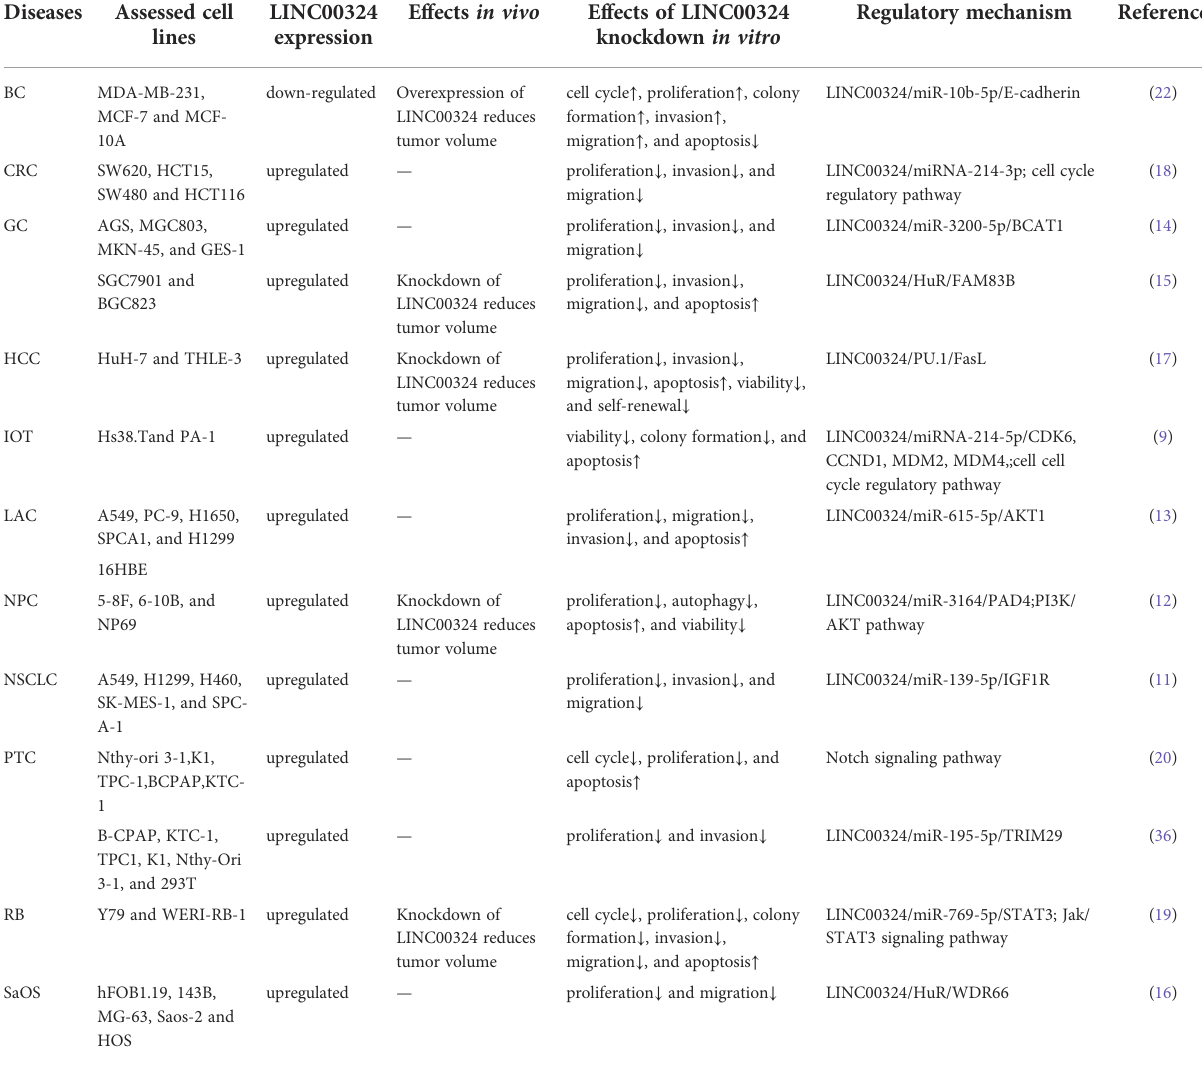
TABLE 1 Regulatory mechanisms of LINC00324 in